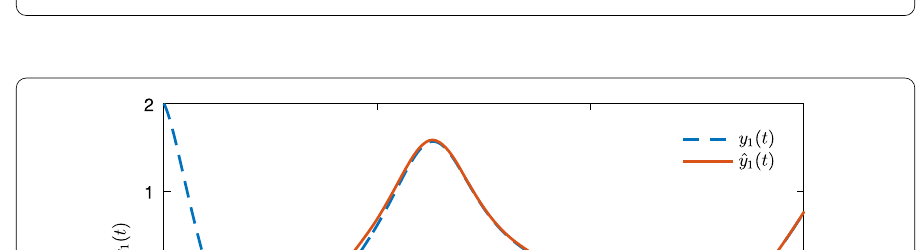
Figure 4 Structure of the dead-zone model